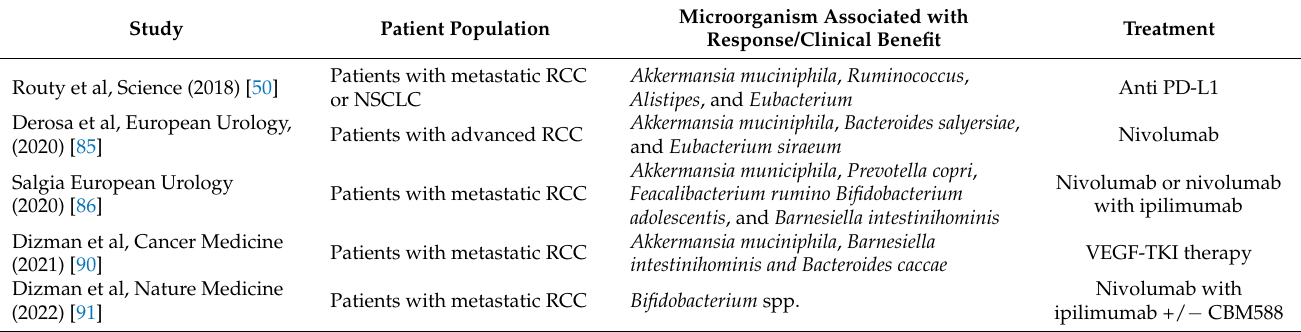
Table 1. Studies evaluating gut microbiome composition and treatment response in mRCC patients. Study Patient Population